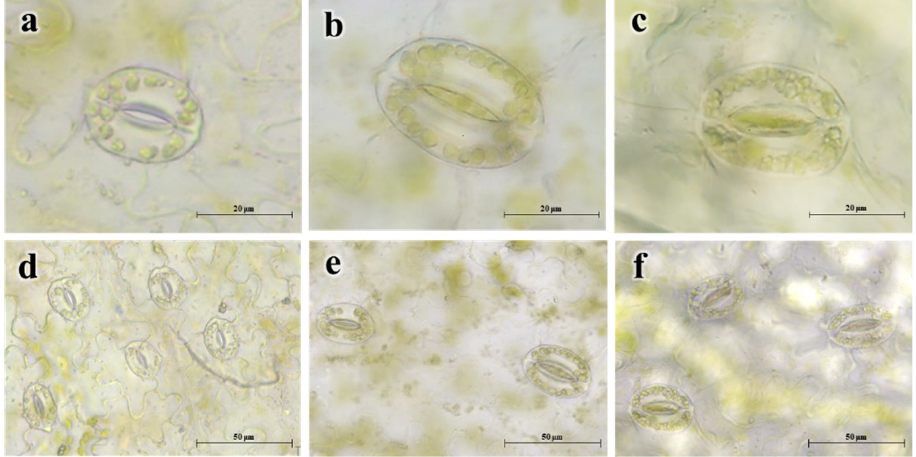
Figure 3. Microscopic analysis of the stomatal complex and chloroplasts in diploid, mixoploid,